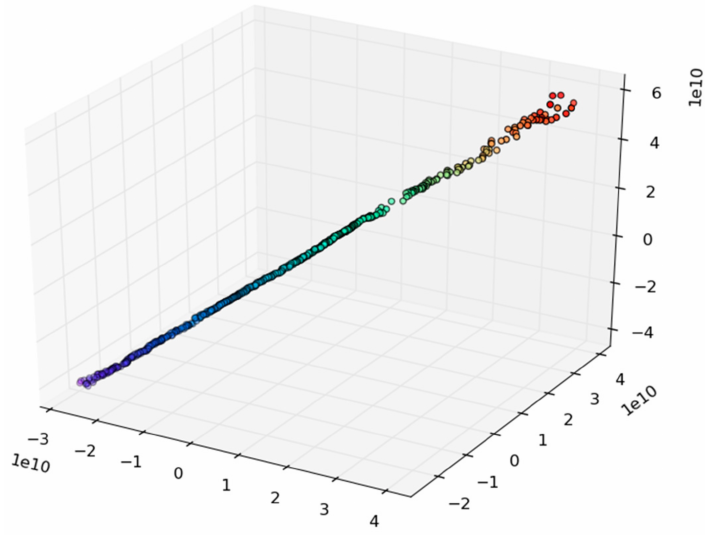
Figure 10. Multidimensional scaling illustration of the testbed communication with Internet of things (IoT) applications